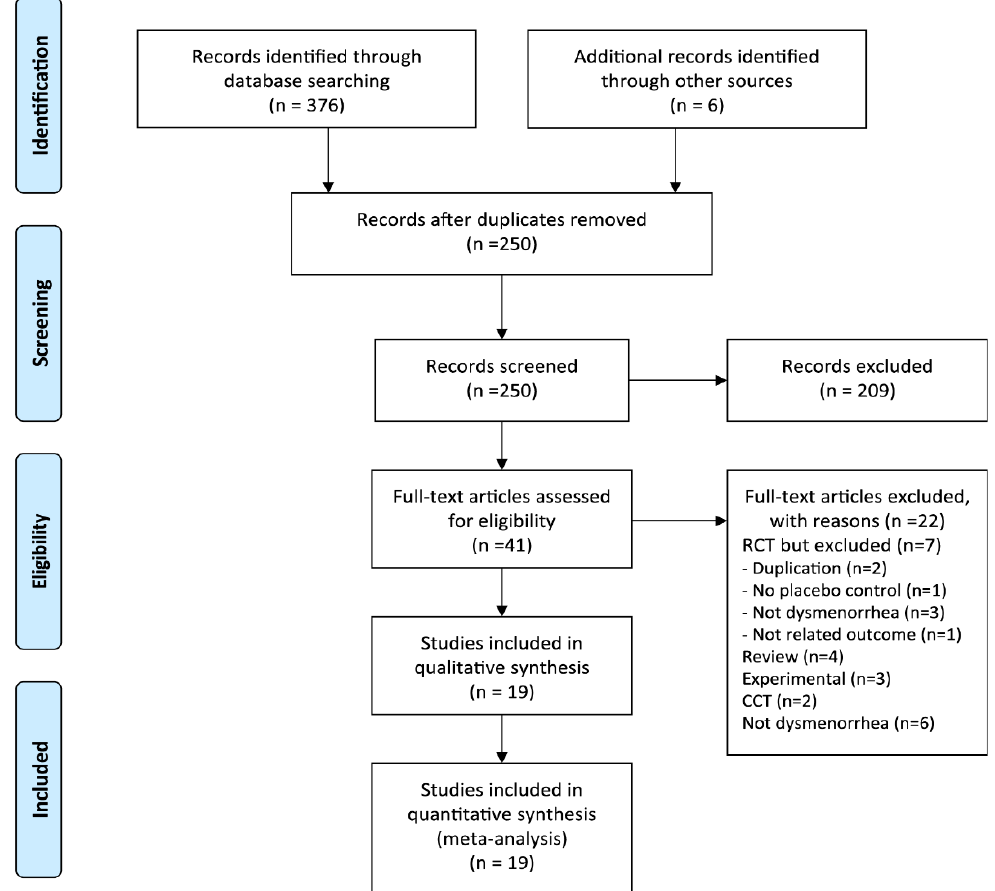
Figure 1. Flow diagram of selection process. CCT: non-randomized controlled trial; RCT: randomized controlled trial.